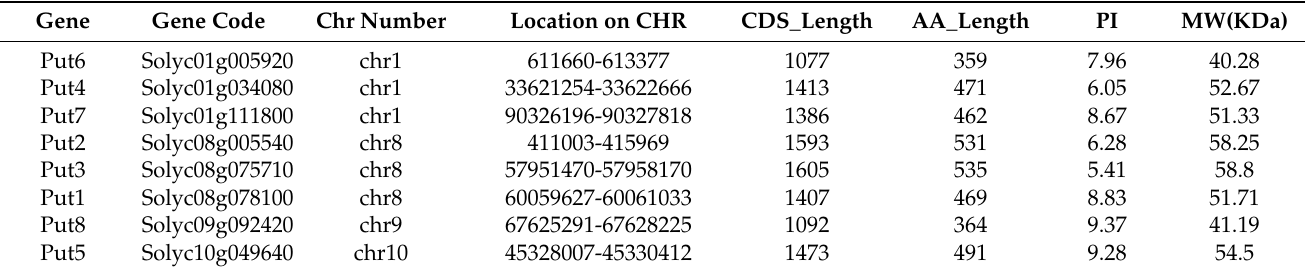
Table 1. Put gene identification and characterization in the